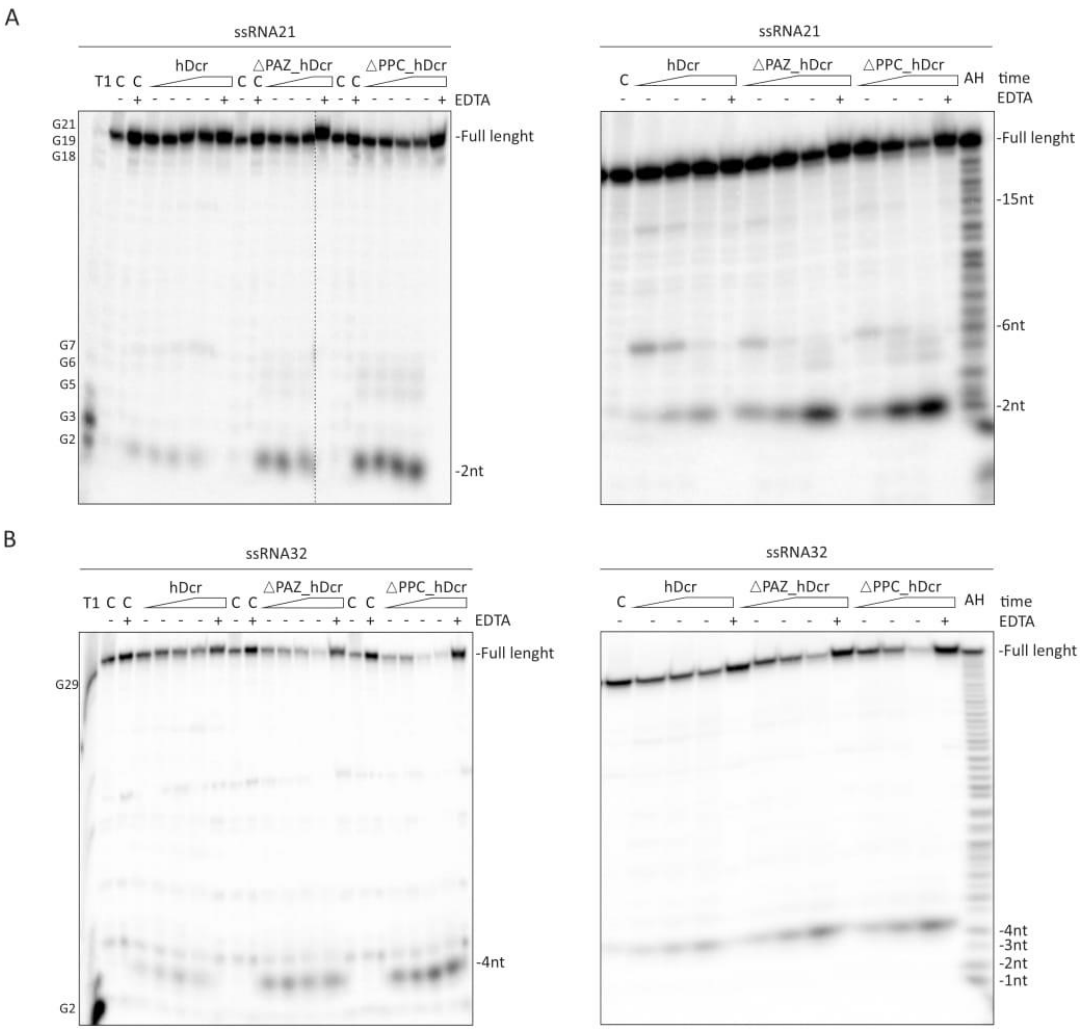
Figure 3. Comparison of the RNase activity of full-length hDicer (hDcr) and the PAZ domain deletion variants ΔPAZ_hDcr and ΔPPC_hDcr on short ssRNA substrates. (A, B; left panels) The results of the RNA-cleavage assays involving: 21-nt ssRNA (A; left panel) and 32-nt ssRNA (B; left panel) , and increasing amounts of the respective protein (hDcr, ΔPAZ_hDcr or ΔPPC_hDcr): 12.5, 25, 50, 75 nM (represented by a triangle). (A, B; right panels) The results of the time-dependent cleavage of 21-nt ssRNA (A; right panel) and 32-nt ssRNA (B; right panel). Triangles represent time points: 15 min, 30 min, 1h. Reactions were carried out with 50 nM protein (hDcr, ΔPAZ_hDcr or ΔPPC_hDcr). ( C- ) controls incubated without a protein. ( C+EDTA ) controls incubated without a protein but with 25 mM EDTA. ( +EDTA ) supplementation of the reaction buffer with 25 mM EDTA. EDTA by chelating the Mg2+ cations present in the reaction buffer, inhibits the RNase III-specific cleavage. (T1) G-ladder generated with RNase T1. (AH) Ladder generated by alkaline hydrolysis of 5′- 32 P-labeled ssRNAs.